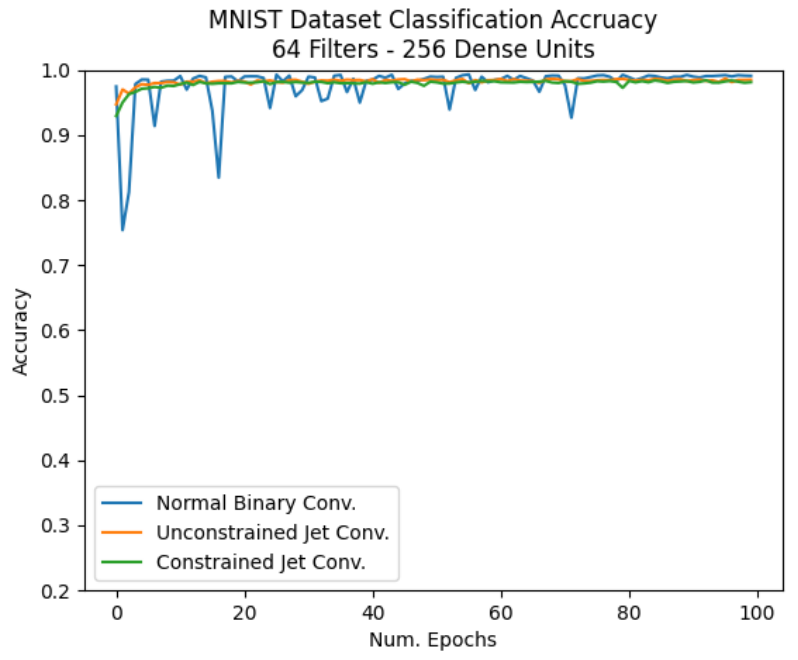
Figure 13. Classification accuracy on the MNIST dataset with 32 filters and 128 dense units.